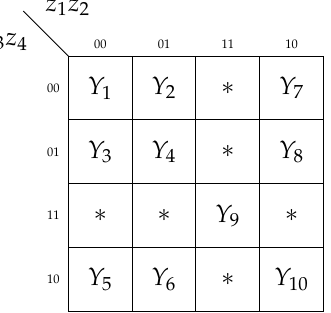
Figure 6. Codes of output